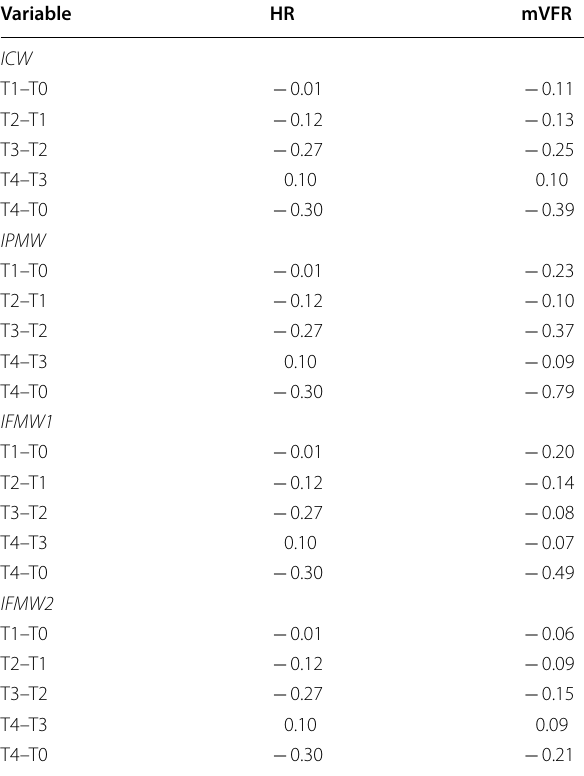
HR indicates Hawley retainer; mVFR, modified vacuum-formed retainer; ICW, intercanine width; IPMW, interpremolar width; IFMW1, interfirst molar mesiobuccal cusp width-; IFMW2, interfirst molar distobuccal cusp width; T0, at debond; T1, 3-month retention; T2, 6-month retention; T3, 12-month